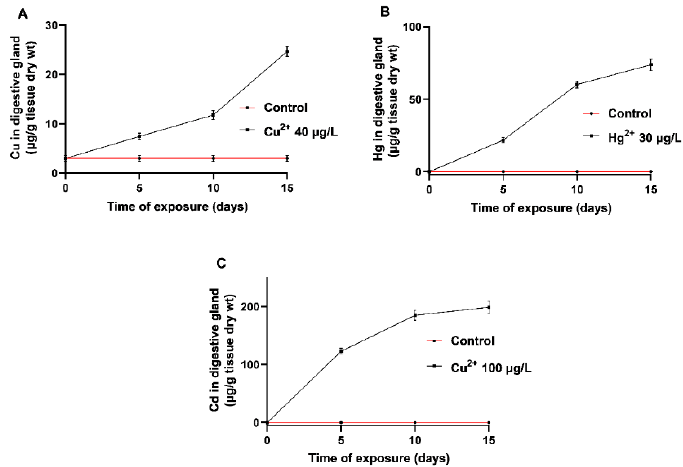
Figure 1. Metal concentrations in digestive glands after mussels exposed for up to 15 days to seawater enriched with di ff erent concentrations of ( A ) CuCl 2 , ( B ) HgCl 2 , and ( C ) CdCl 2 . After acclimation at 18 ◦ C for 1 week in tanks containing natural seawater from a non-polluted area, mussels were exposed to natural seawater or to seawater containing 40 µ g / L Cu, 30 µ g / L Hg, or 100 µ g / L Cd. Depicted concentration values represent the means from five independently performed experiments, while standard deviations were lower than 5%.